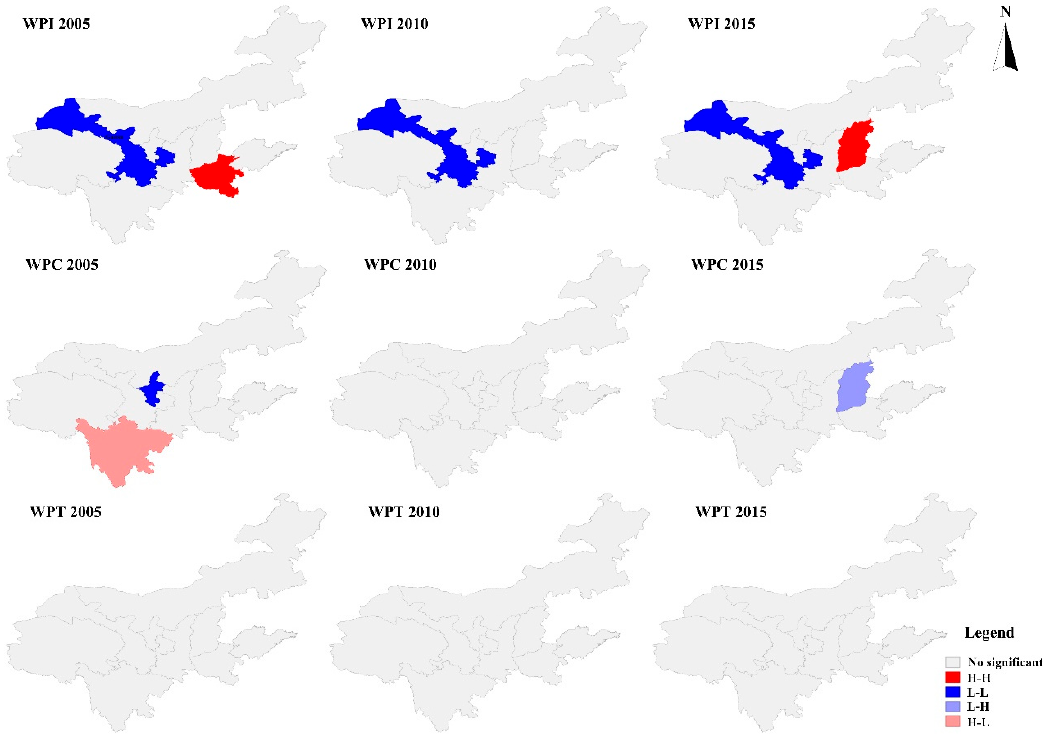
Figure 3. LISA cluster diagram of water productivity in the Yellow River Basin in 2005, 2010, and 2015.